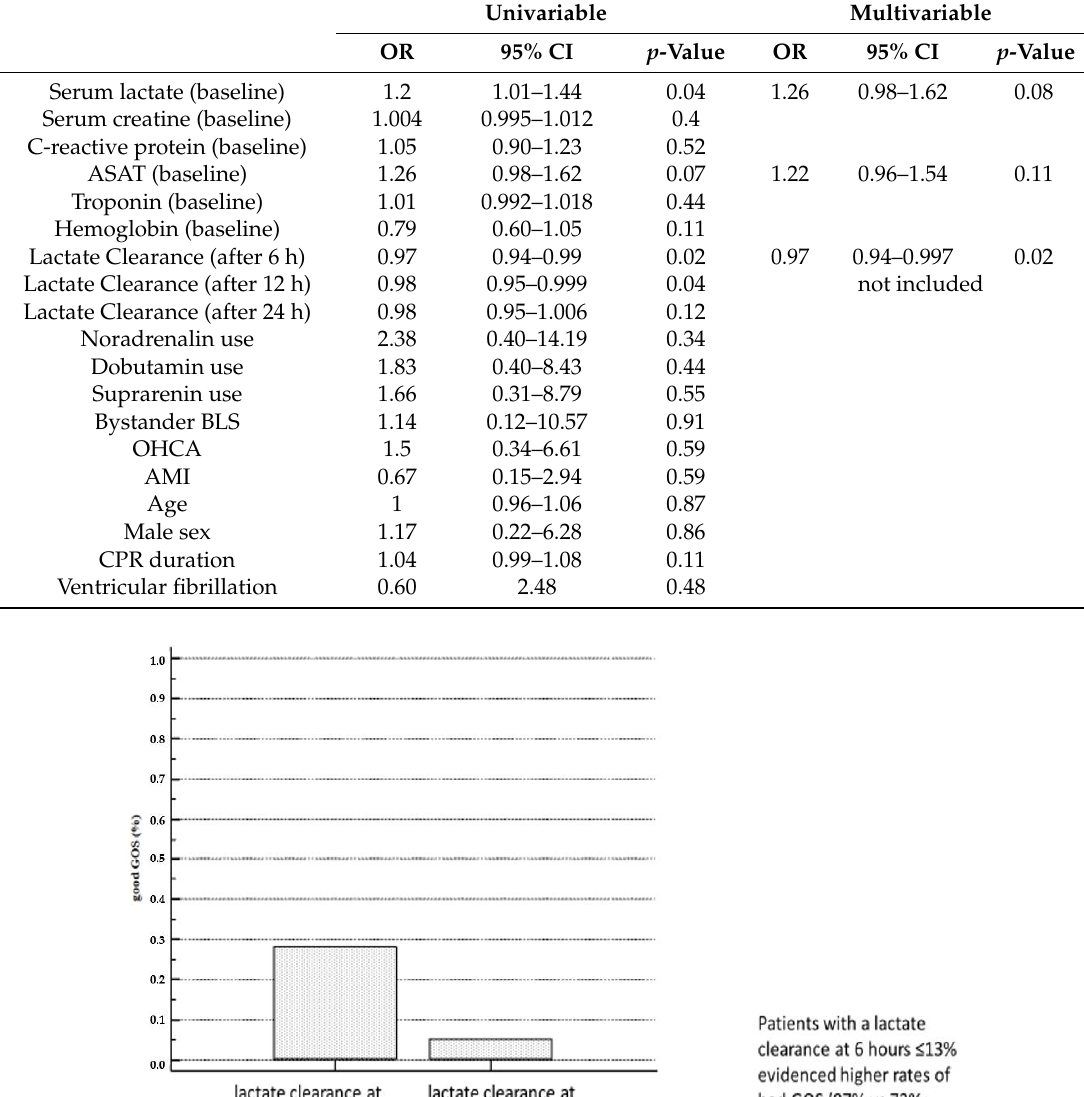
Table 4. Univariable and multivariable analysis of parameters predicting the neurological outcome based on Glasgow Outcome Scale.